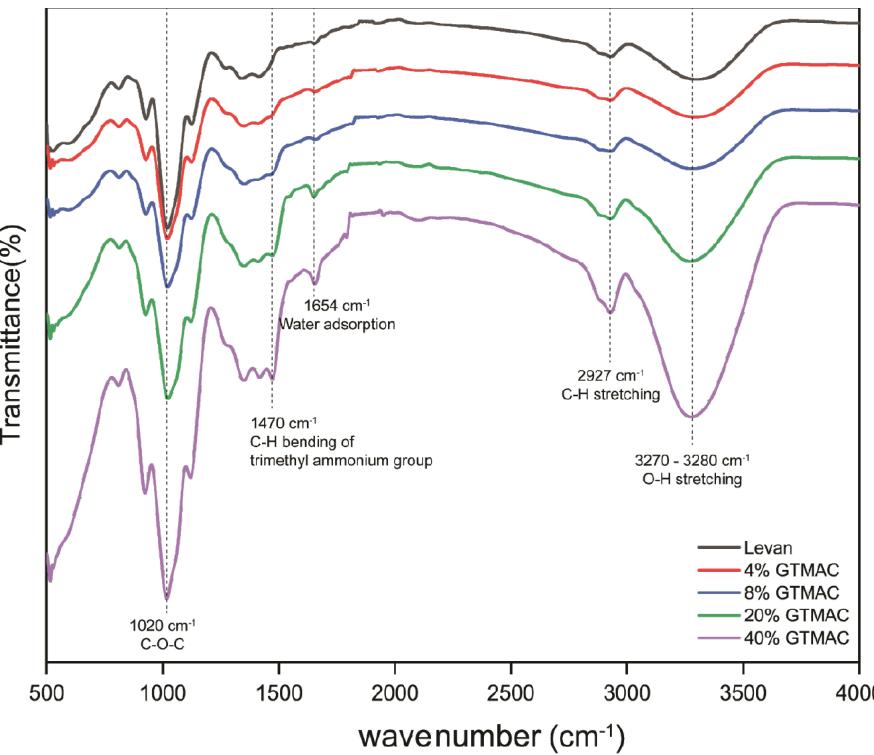
Figure 1. The FT − IR spectra of levan and QA − levan obtained from different GTMAC concentration.